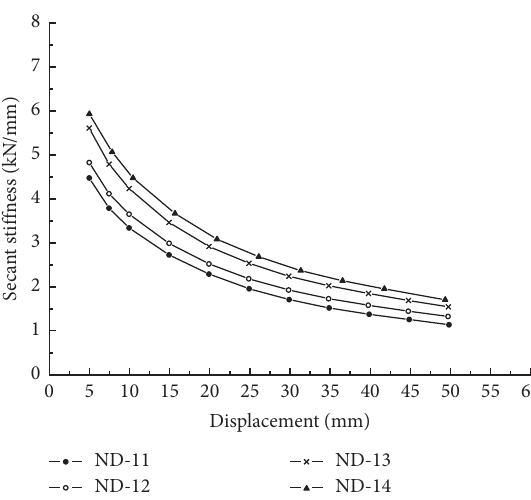
Figure 25: Stiffness curves of slit width 60mm.